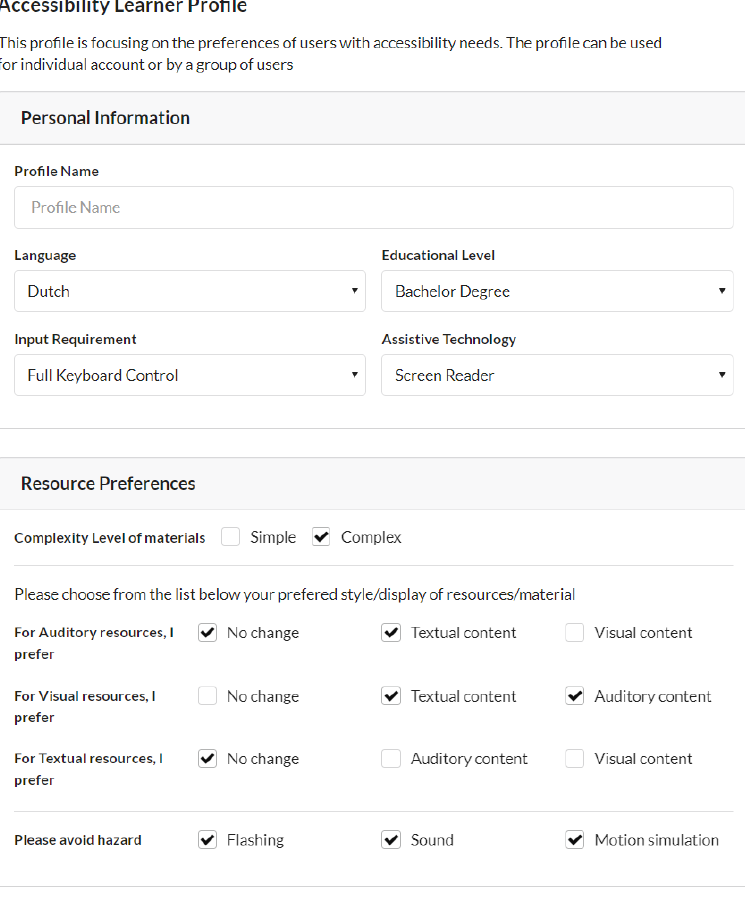
Figure 4. Accessibility learner profile